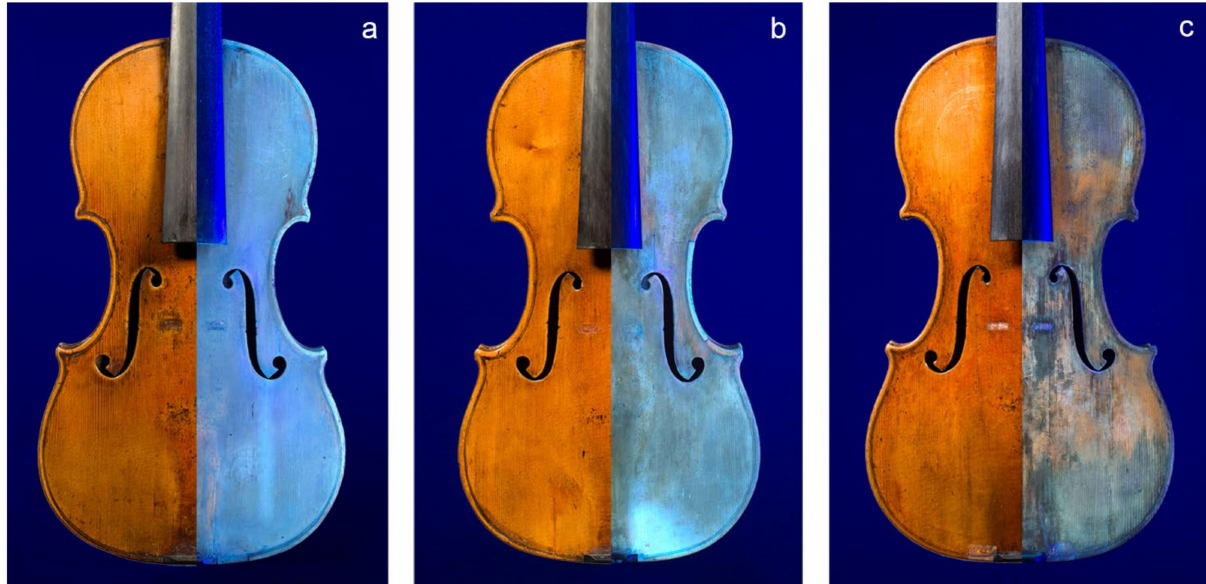
Figure 1. Visible (left) and UV (right) images of the soundboard of ( a ) the “Spagnoletti”, ( b ) the “Stauffer”, and ( c ) the “Principe Doria” made by Giuseppe Guarneri “del Ges ù ” in 1734. Visible and UV images of the back plates are shown in Figure S1 in the Supplementary